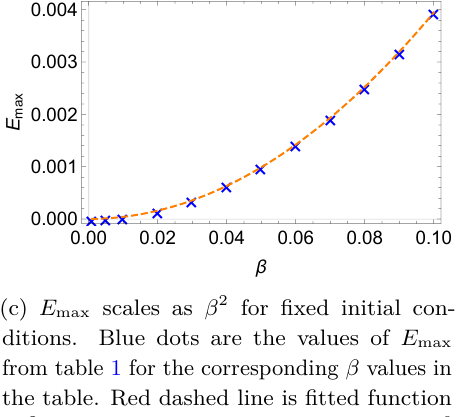
Blue dots are the values of γ from table 1 for the corresponding β values in the table. Red dashed line is fitted function aβ 2 + b with a = 2 . 00568 and b = − 6 . 056 × 10 − 6 .